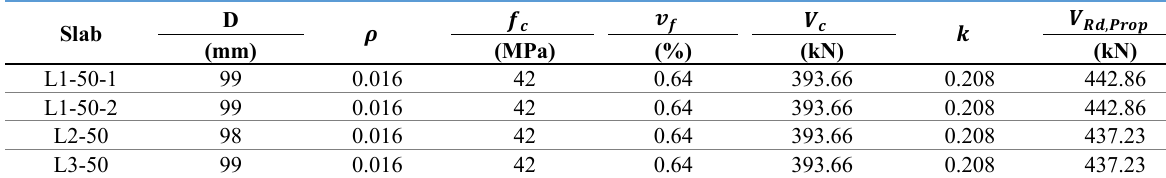
Table 9. Estimative of the load-carrying capacity – Proposed model Slab